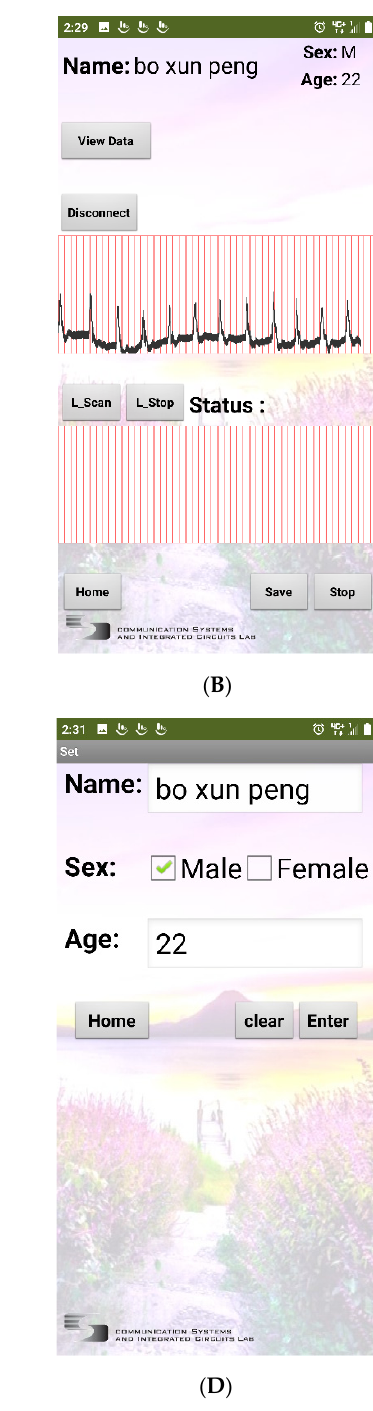
Figure 18. Mobile app usage pictures. ( A ) Home page, ( B ) Connection interface, ( C ) Reading the EMG data, ( D ) User data settings.